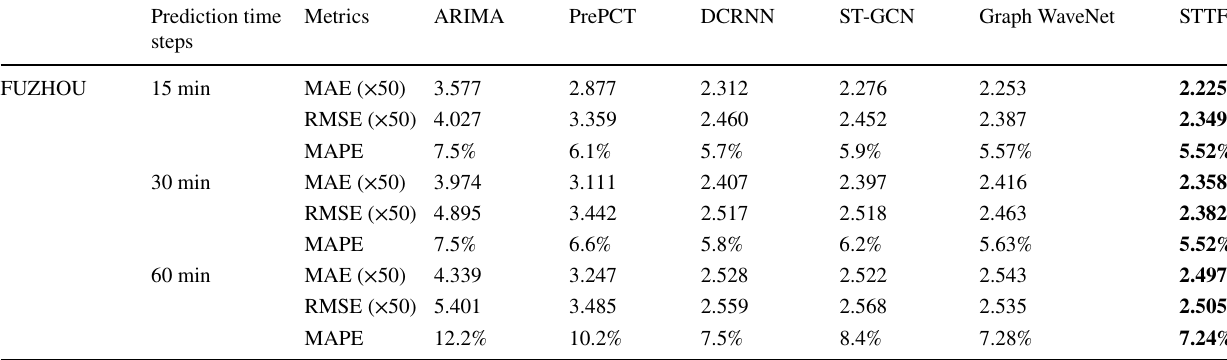
Table 1 Performance of each model in FUZHOU database under different prediction time step (predictions are made every 30 minutes and the optimal values under the same time step are bolded)